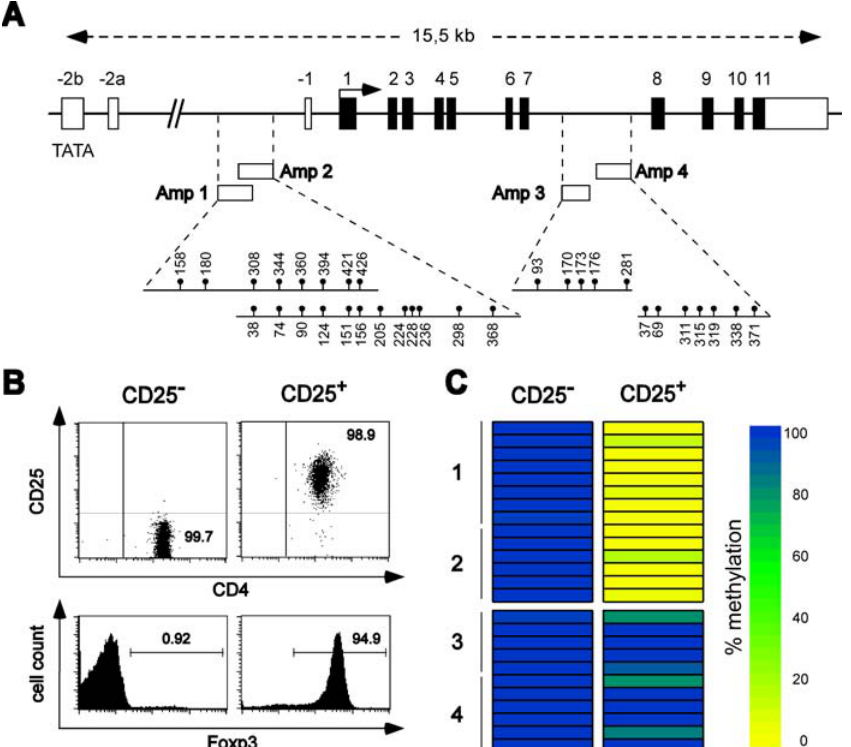
Figure 2. Selectively Demethylated CpG Motifs within the foxp3 Locus in CD25 þ CD4 þ Tregs Isolated from Secondary Lymphoid Organs (A) Schematic view on the foxp3 locus depicts exon-intron structure and position of selected amplicons (Amp 1–4). Shown is the distribution and position of individual CpG motifs within the amplicons. (B) CD25 þ CD4 þ and CD25 (cid:1) CD4 þ T cells were sorted from spleens and LNs pooled from 20 male BALB/c mice. FACS analysis shows the sort purity (upper panel) and Foxp3 expression in sorted subsets (lower panel). Numbers display frequency of cells within indicated populations. The bars in the lower graphs indicate the marker gate for Foxp3 þ cells. The vertical and horizontal lines in the upper graphs indicate the quadrant used to identify the CD4 þ CD25 þ / (cid:1) subsets. (C) Methylation pattern of selected amplicons of the foxp3 locus in CD25 þ CD4 þ Tregs and conventional CD25 (cid:1) CD4 þ T cells. The amplicons are subdivided by horizontal lines each representing an individual CpG motif. ESME software [47] is used for normalization and quantification of methylation signals from sequencing data by calculating ratios of T and C signals at CpG sites. Data are condensed to methylation information at CpG positions forming matrices of consecutive CpGs. The methylation status of individual CpG motifs within the four amplicons is color coded according to the degree of methylation at that site. The color code ranges from yellow (0% methylation) to blue (100% methylation) according to the color scale on the right. CpG motifs from amplicon 2 overlapping with motifs in amplicon 1 were excluded. Due to sequencing problems, the CpG motif 37 from amplicon 4 is not listed. One representative experiment out of two individual experiments is shown.